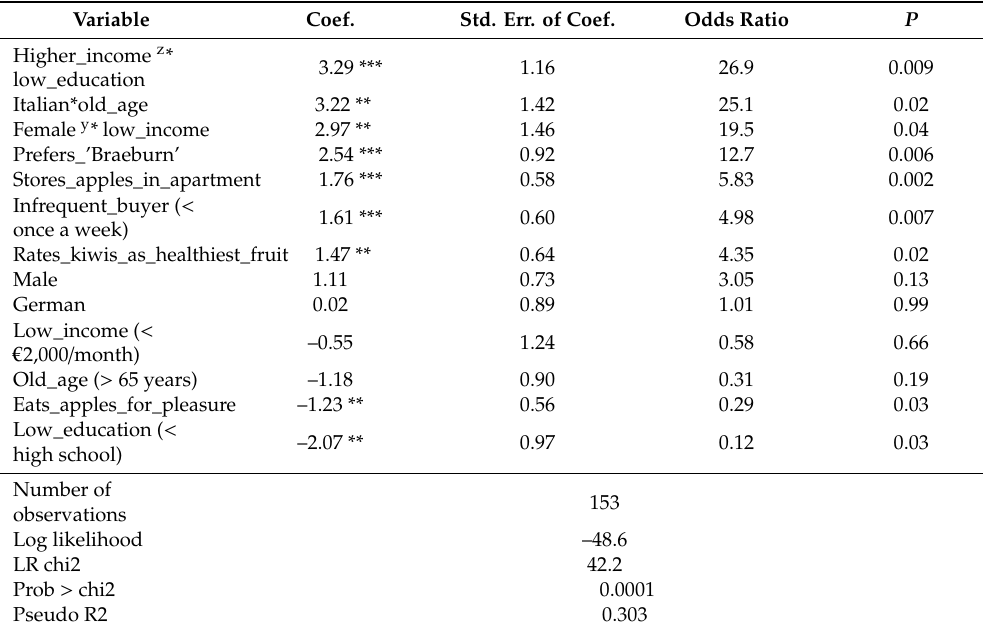
Table 4. Logit regression—variables a ff ecting the likelihood of being a declining apple